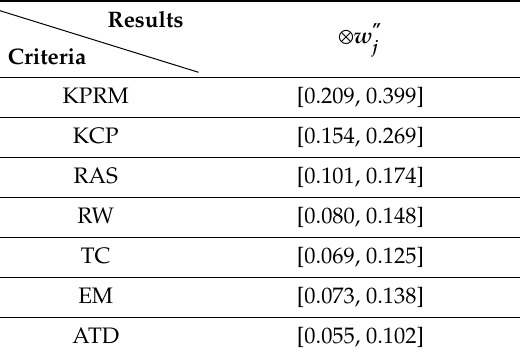
Table 8. The final grey